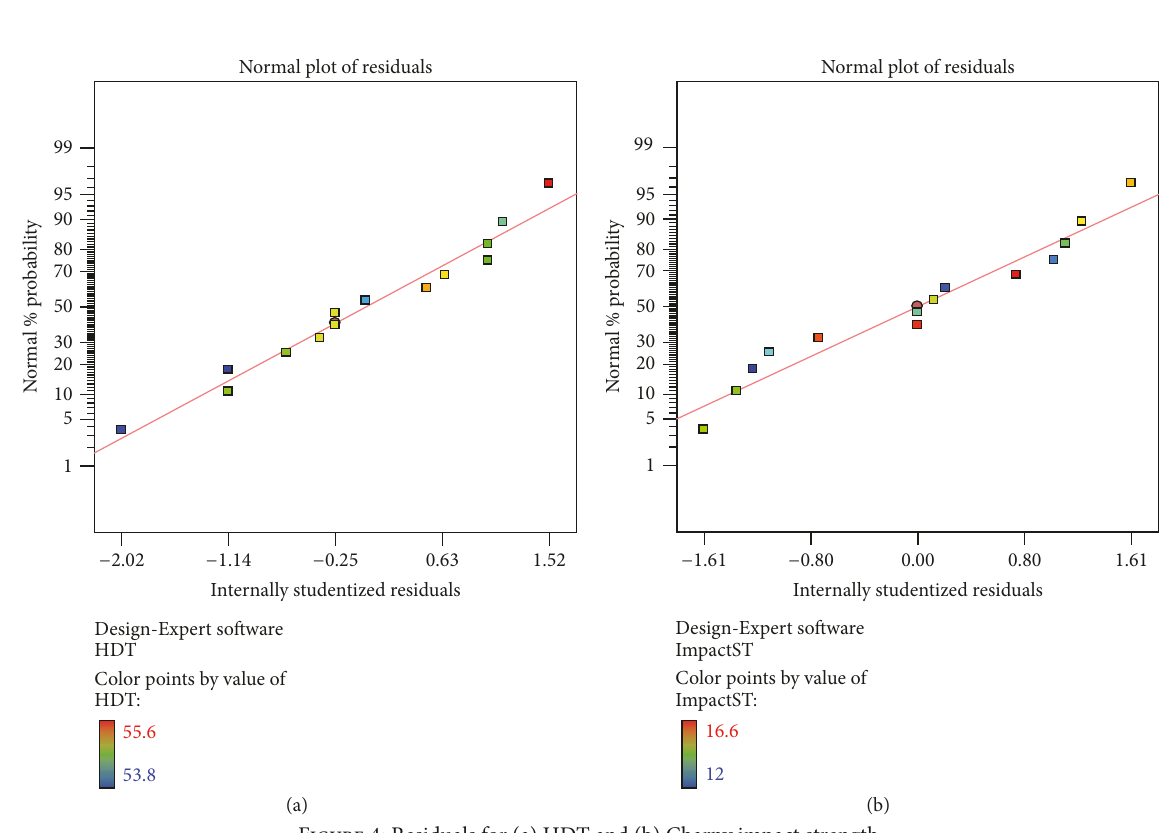
Figure 3: Residuals for flexural mechanical properties.